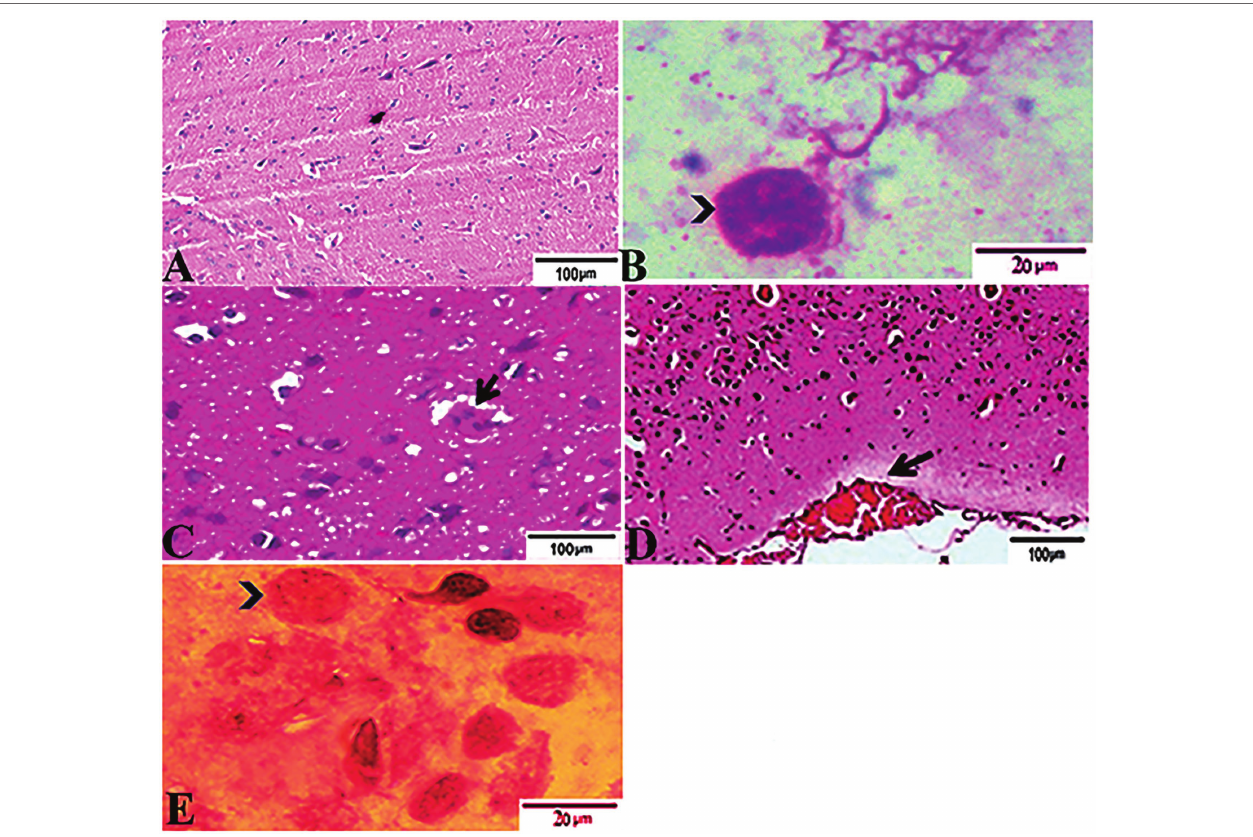
FIGURE 6 | Photomicrograph of brain sections from experimental mice groups stained with Hx&E stain: (A) a mice brain from the control group demonstrating normal brain architectures. (B) Brain tissue section from control positive group infected by Toxoplasma gondii showing; the presence of T. gondii cysts (arrowhead). (C) Brain sections from the group treated for 14 days showing: degenerated T. gondii tissue cysts in the white matter of the infected cerebrum (arrow). (D,E) Brain tissue section from the treated group for 28 days showing: (D) hemorrhages in pia mater (arrow), (E) exhibited the presence of multiple T. gondii tissue cysts in brain tissue (arrowhead). The bar size of each picture was indicated under each